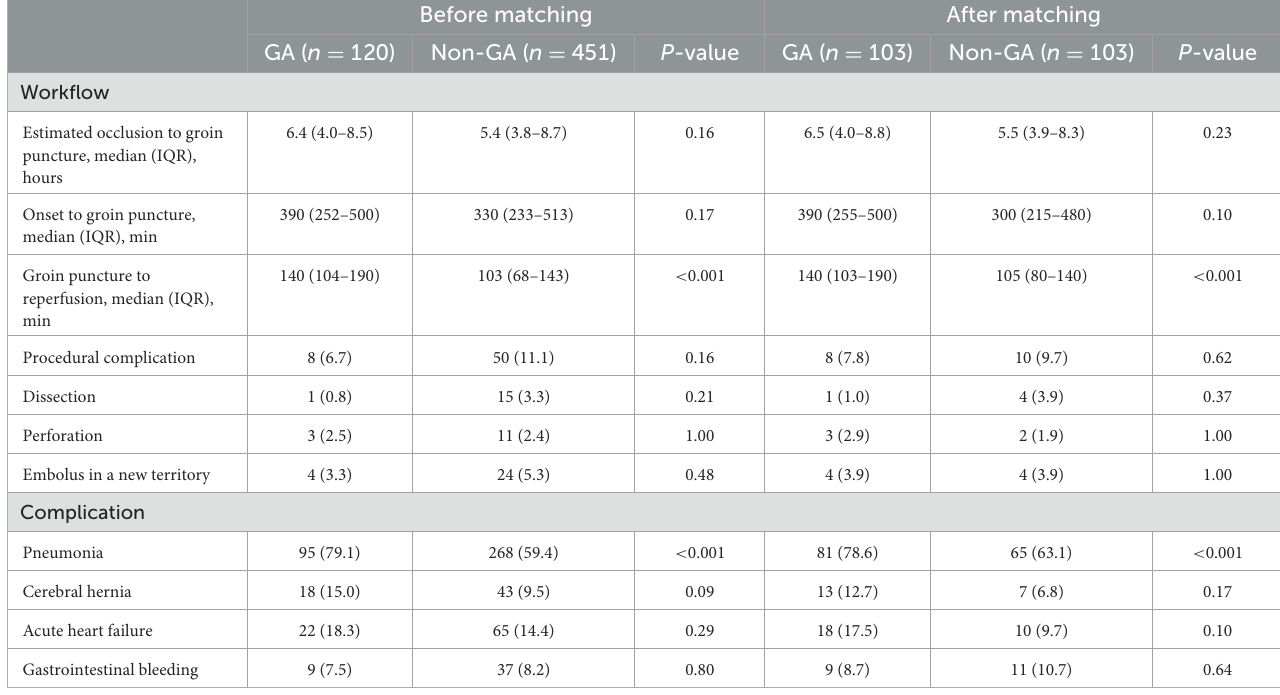
TABLE 2 Procedural-related outcomes and complication according to anesthetic approach in VBAO patients admitted for thrombectomy before and after propensity score matching. Before matching